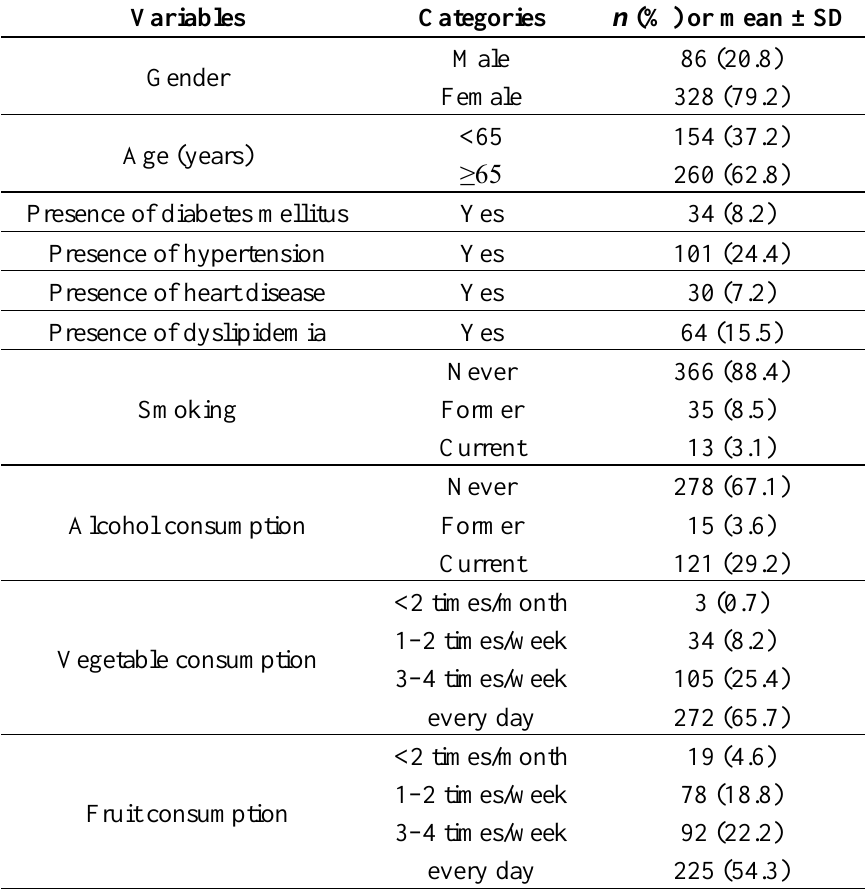
Table 1. Characteristics of the participants ( n =